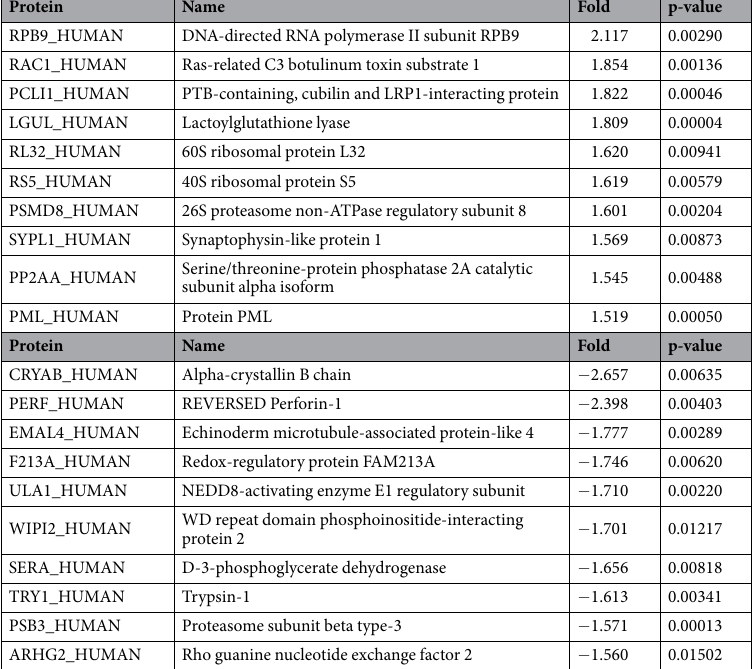
Table 3. Differentially expressed proteins in Group 2.